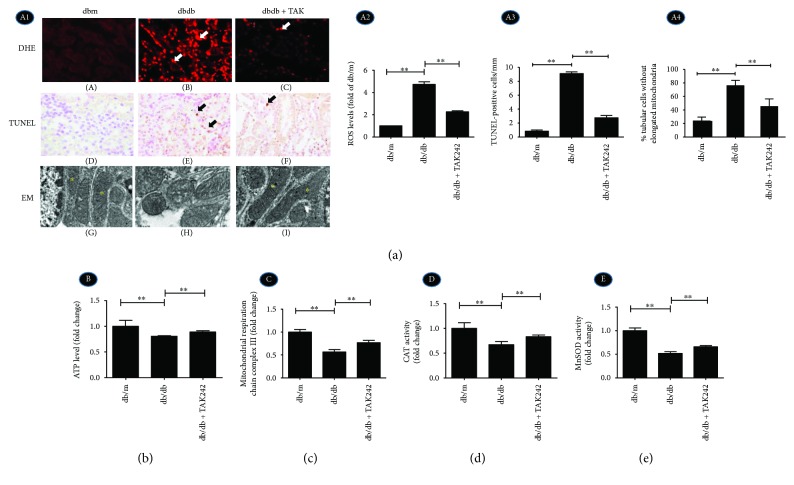
Inhibition of TLR4 protects tubular cells from mitochondrial-dependent apoptosis by regulating mitochondrial structure and function in diabetic dbdb mice. (a) A1, A–C: DHE with red fluorescence for ROS accumulation; A1, D–F: IHC of TUNEL assay for apoptosis (arrow show) (magnification ×400); A1, G–I: EM shows tubular mitochondria of renal tubular cells of dbdb mice (magnification ×20000). A2: Quantification of DHE staining expressed as fold of dbm mice. A3: Quantification of TUNEL-positive cells. A4: Relative percentage of renal tubular cells without elongated mitochondria. (b) The level of ATP production. (c) The activity of mitochondrial respiratory chain complex III. (d) Activity of CAT. (e) Activity of MnSOD. ∗∗P < 0.01. The values in (b–e) were displayed as fold change compared to the control.